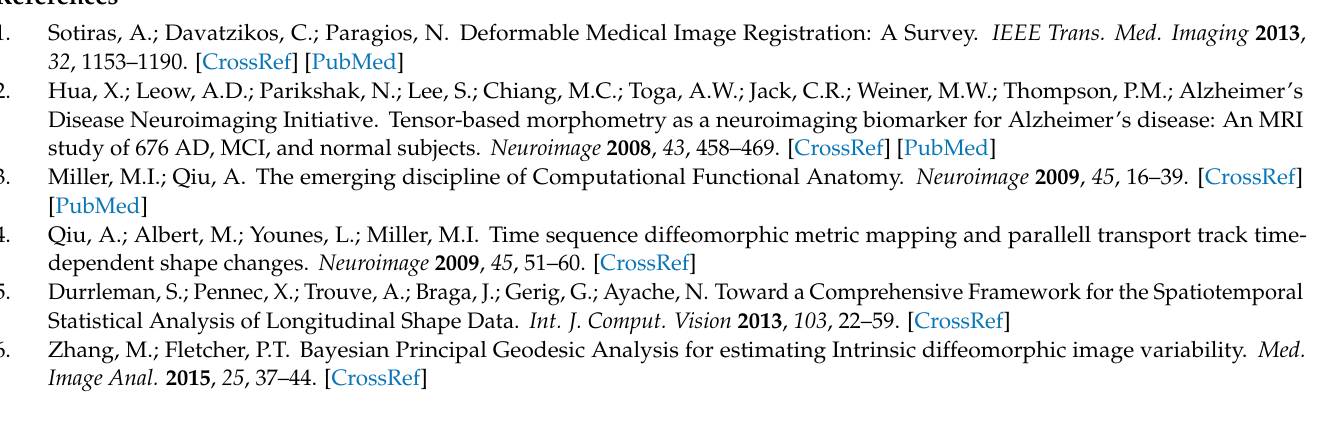
), and the Jacobian g k k ∞ , rel ) − 1 . 1